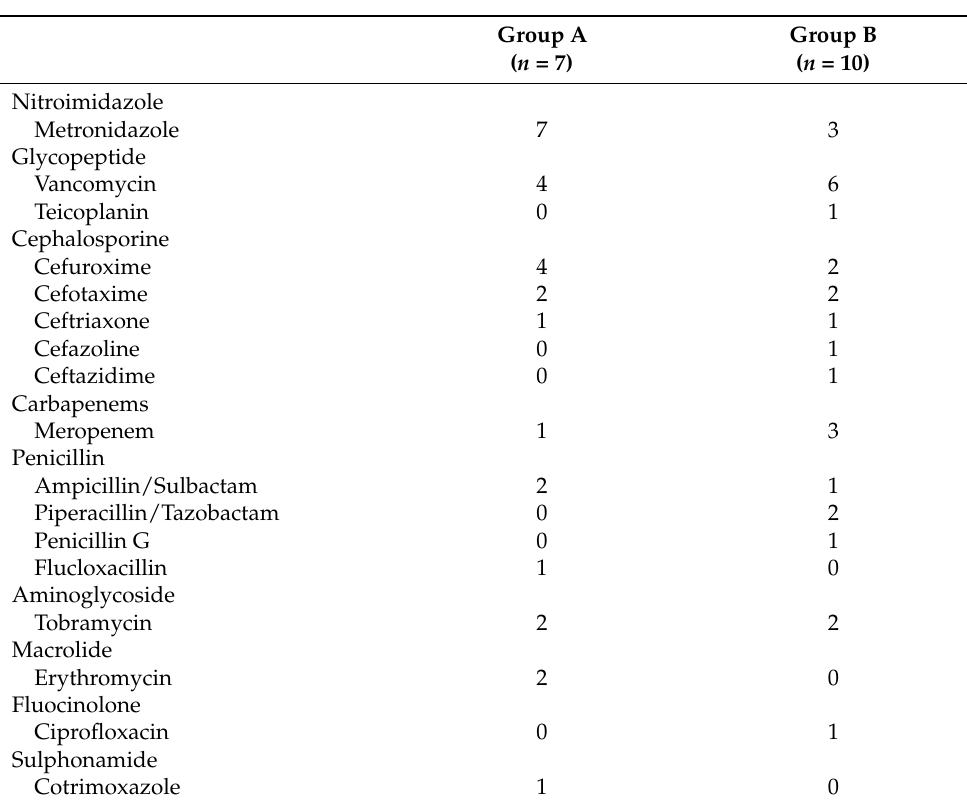
Table 3. Antibiotics used during perioperative patient